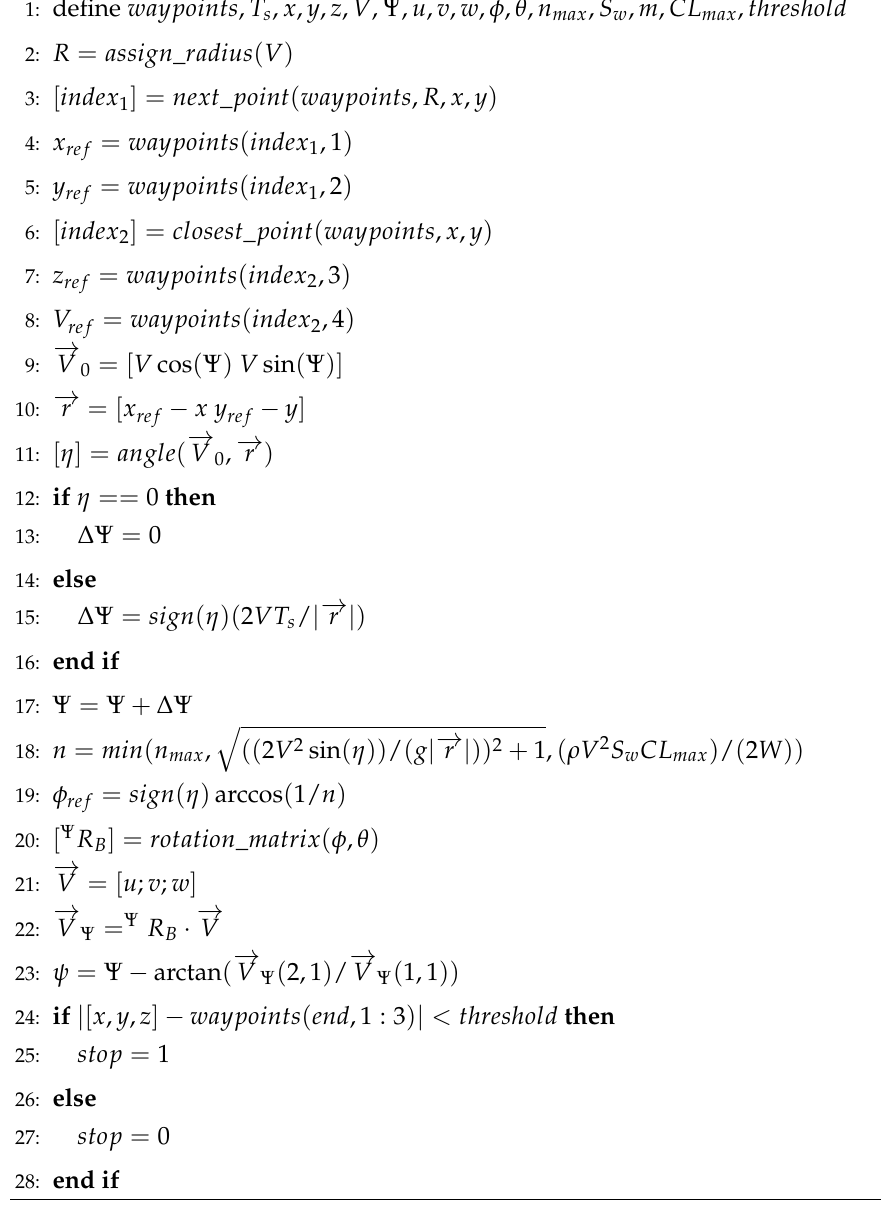
Algorithm 5 Nonlinear guidance